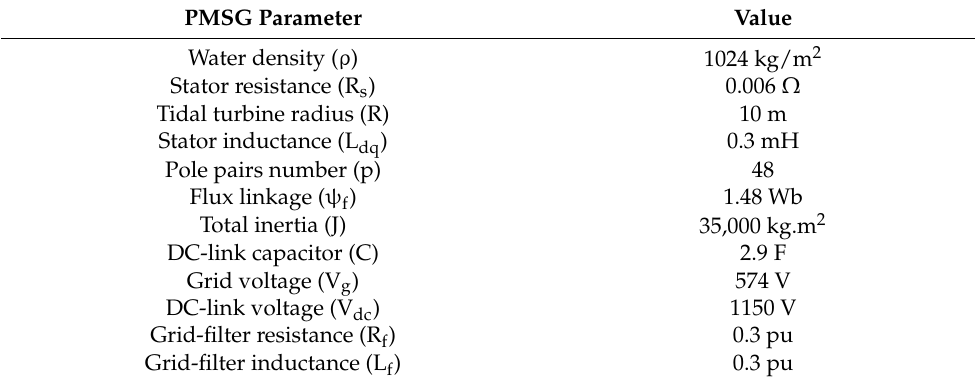
Table 2. System parameters.